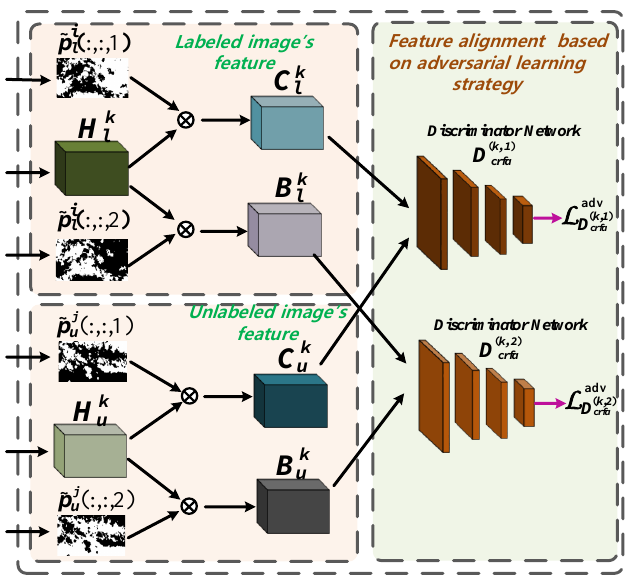
Figure 4. Structure of the proposed class-relevant feature alignment